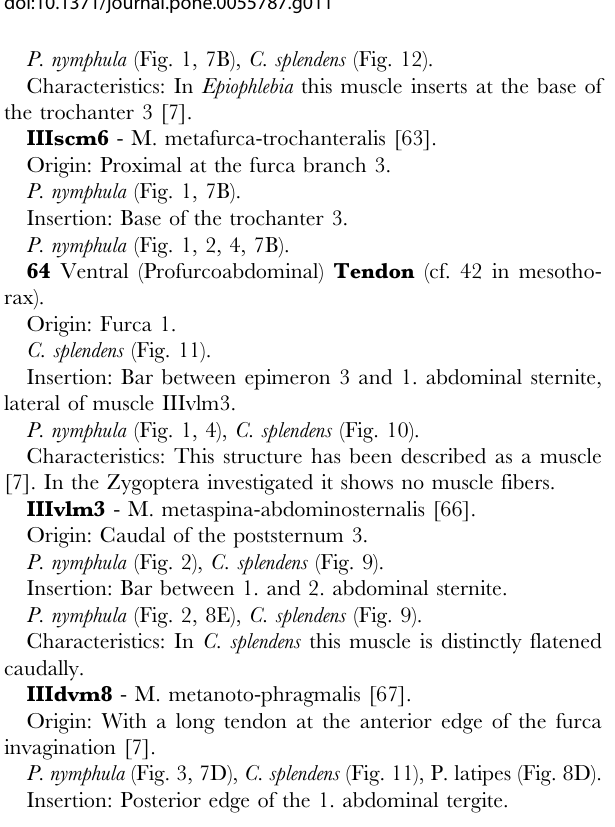
Figure 11. C.splendens , thorax musculature, longitudinal cut, right. Abbreviations: A – anal vein, Abd – abdominal segment, AC – antecosta, AxL – axillary ligament, AxP – axillary plate, C – costa, Cu – cubitus, Cx – coxa, M – media, pCP – proximale costal plate, R – radius, Sc –